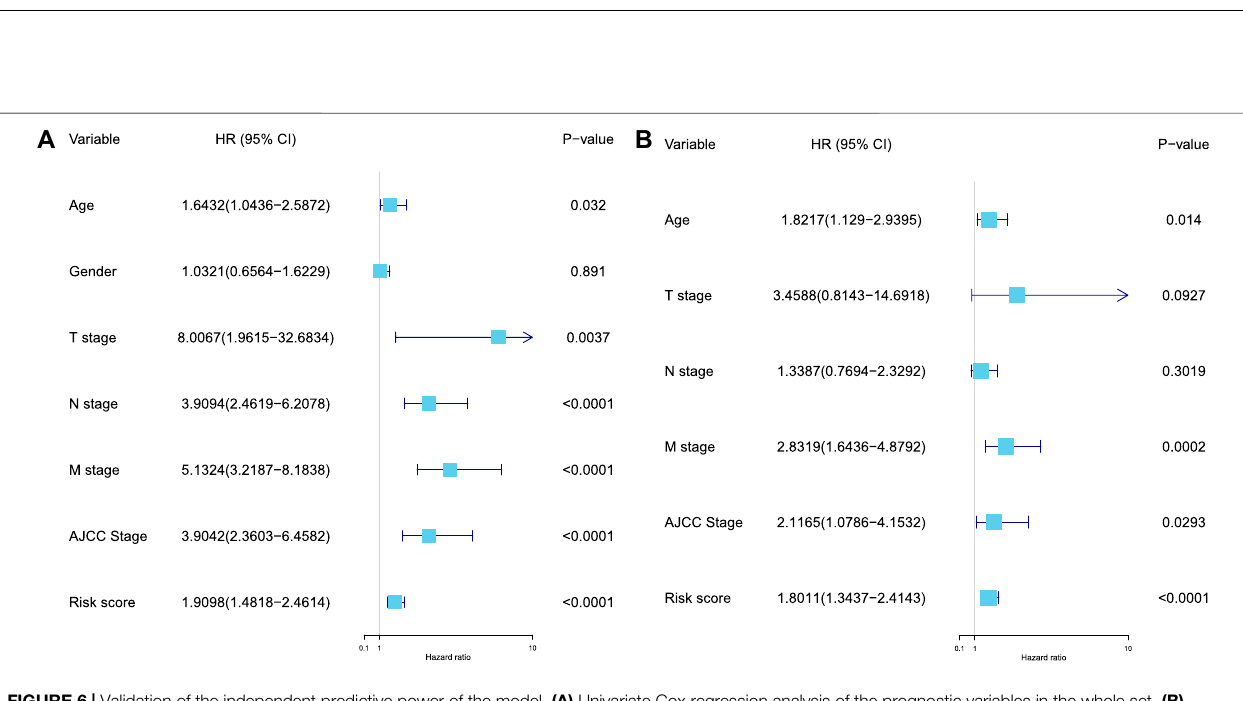
Frontiers in Genetics |